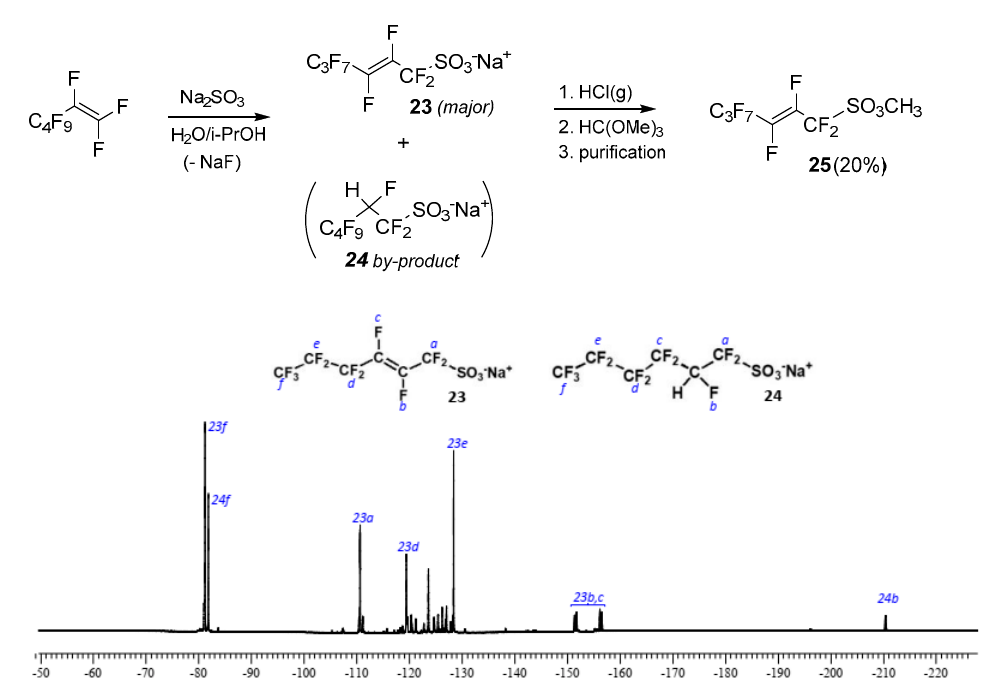
Figure 1. Nucleophilic displacement strategy for sulfonic esters and sulfonate salts 23 – 24 distribution by 19 F spectrum of the reaction mixture obtained by the treatment of perfluorohex-1-ene with SO 32 − . In the spectrum, the following assignments are possible according to the literature [39]: CF 3 - triplets (23f and 24f) at δ -81.22 ppm, intensity 1 (allylic product 23 ) and δ -81.86 ppm, intensity 0.5 (addition product 24 ); -CF = CF- at δ − 153.83 ppm (23b,c), AB spin system, J(AB) 139.8 Hz; -CFH- at δ − 210.44 ppm, 2 J F,H 30.5 Hz (24a); -CF 2 -S- at δ -110.6 ppm (23a); -CF 2 - at δ − 119.40 ppm and 128.44 ppm (23d and 23e, respectively). The CFH group of the addition product creates a magnetic inequivalence of neighbor CF 2 -groups (-CF 2 -CFH-CF 2 -SO 3 Na) and thus AB spin systems ( δ from − 108 to − 127.5 ppm), which has not been specified in detail (signals attributable to fluorine atoms 24a,c,d,e).